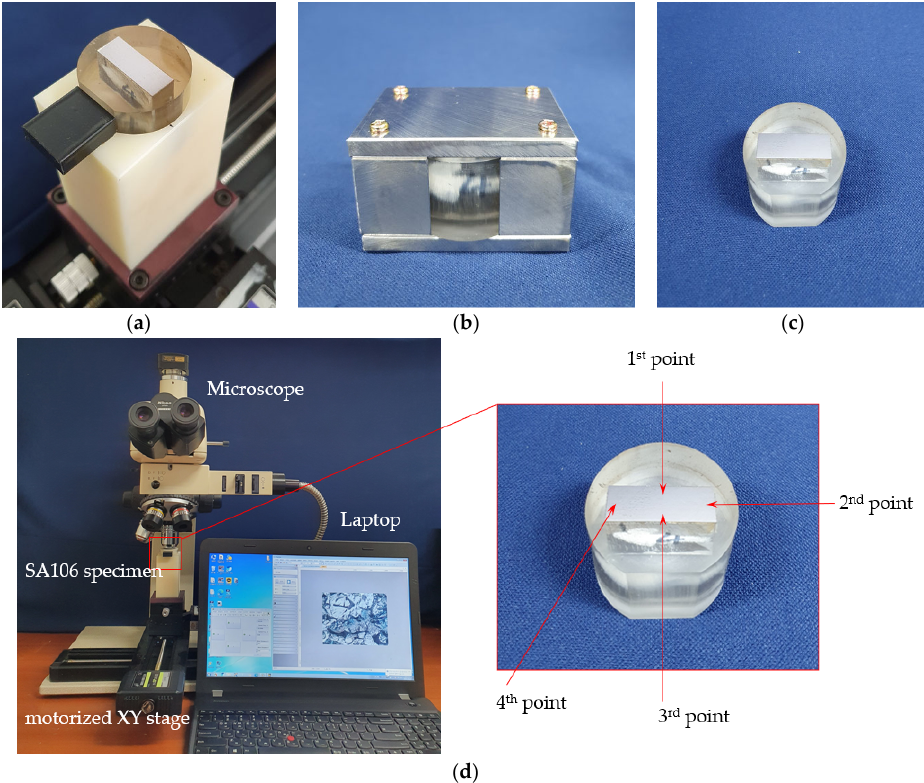
Figure 1. Specimen adjustment to reduce positioning error. ( a ) Mounted specimen; ( b ) Jig for key ‐ hole; ( c ) After grinding Mounted specimen; and ( d ) Set specimen on the XY ‐ stage using the key and key ‐ hole. Table 1. Height of the polished sample at each layer.